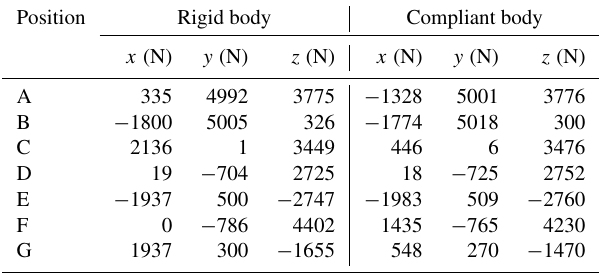
Table 6. Forces acting at hardpoints in front suspension system in rigid-body and compliance models.